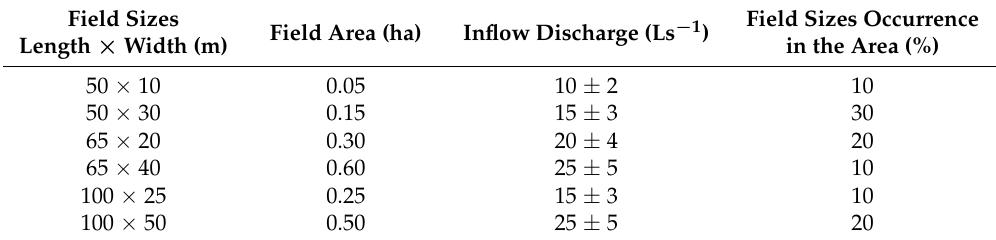
Table 2. Field sizes and inflow discharges observed in Dengkou.